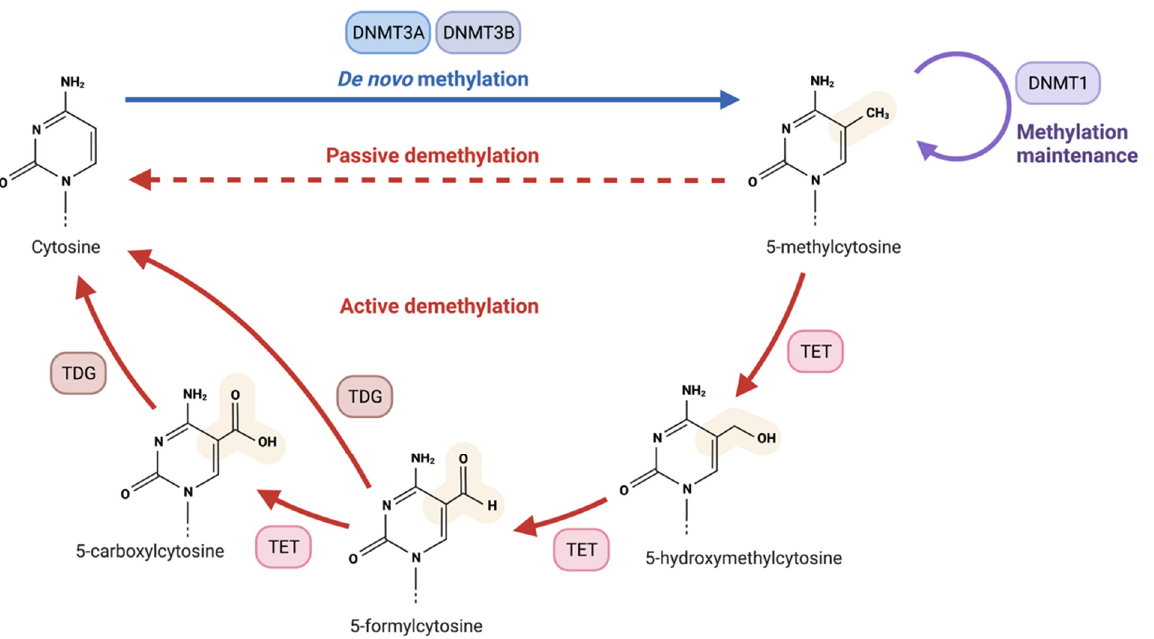
Figure 3. Pathway of DNA Methylation and Demethylation The de novo methylation of cytosine is carried out by DNMT3A and DNMT3B, with methylation being maintained during cell replication by DNMT1. 5-methylcytosine (5mC) is demethylated via two pathways. Passive demethylation occurs due to the failure to maintain methylation after cell division, resulting in the gradual dilution of methylated cytosines. In contrast, the process of active demethylation is catalysed by the TET enzymes (TET1–TET3), which oxidise 5mC to 5-hydoxymethylcytosine (5hmC), 5-formylcytosine (5fC) and 5-carboxylcytosine (5caC). 5fC and 5caC are substrates for thymine–DNA–glycosylase (TDG) which leads to the excision of the oxidised cytosine base. The resulting abasic site is repaired via base excision repair to restore the original cytosine molecule. Figure from Biorender.com.